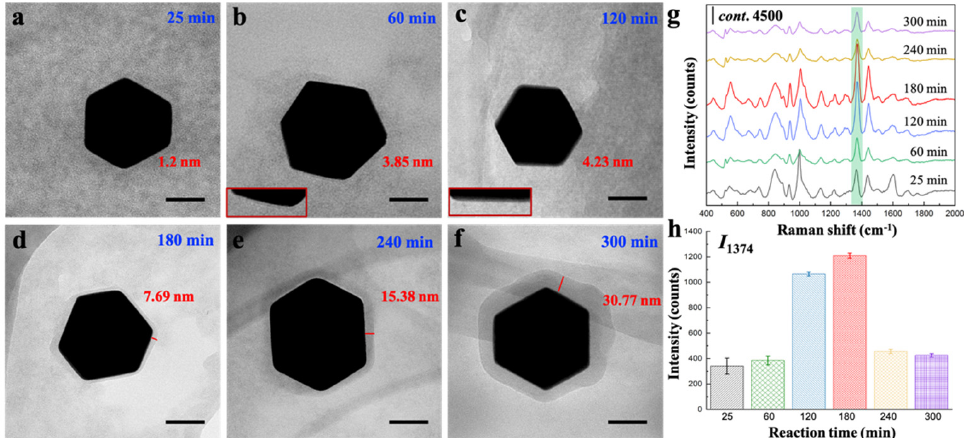
Figure 2. ( a − f ) Representative TEM images of core − shell Au@BUT − 17 NP with increased shell thick ‐ ness. Scale bar: 50 nm; ( g ) SERS spectra of thiram; and ( h ) the comparison of I 1374 in the presence of Au@BUT ‐ 17 prepared in different reaction time ranged from 25 min to 300 min.